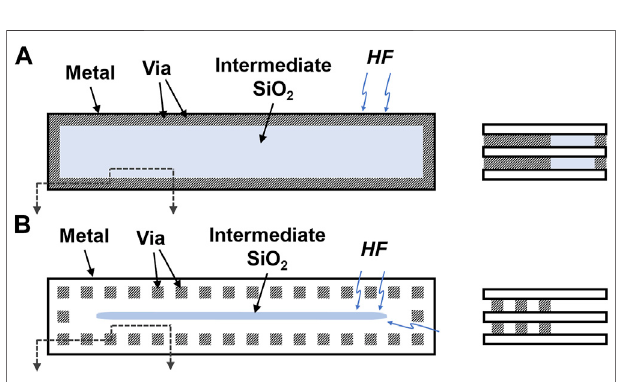
FIGURE 2 | Illustration of the oxide layer after release if the VIA wall is allowedornot. (A) TheCMOS-MEMSprocessusedinLuetal.(2018a),where thetungstenVIAisallowedtohaveacontinuous “ wall ” toprotecttheenclosed intermediate oxide from being etched by the release etchant. (B) If VIA “ wall ” is not